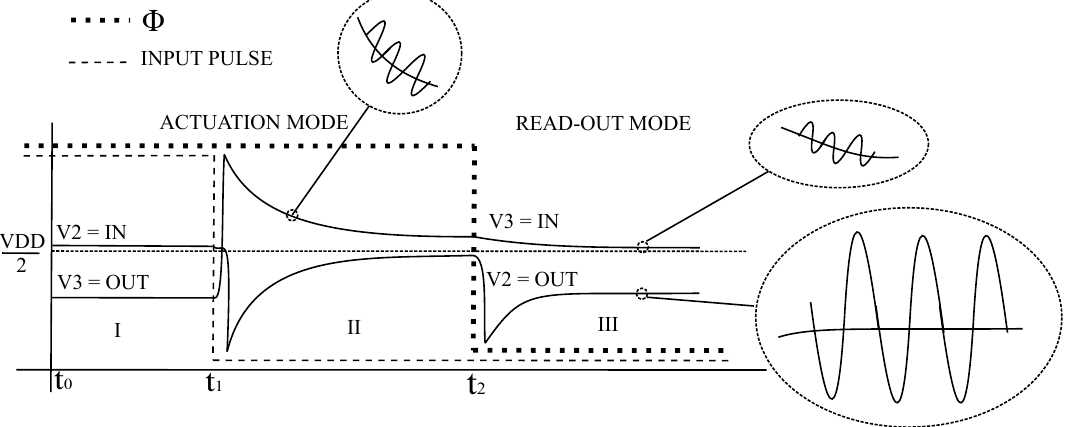
Figure 14. Analysis of the transition: actuation mode to read-out